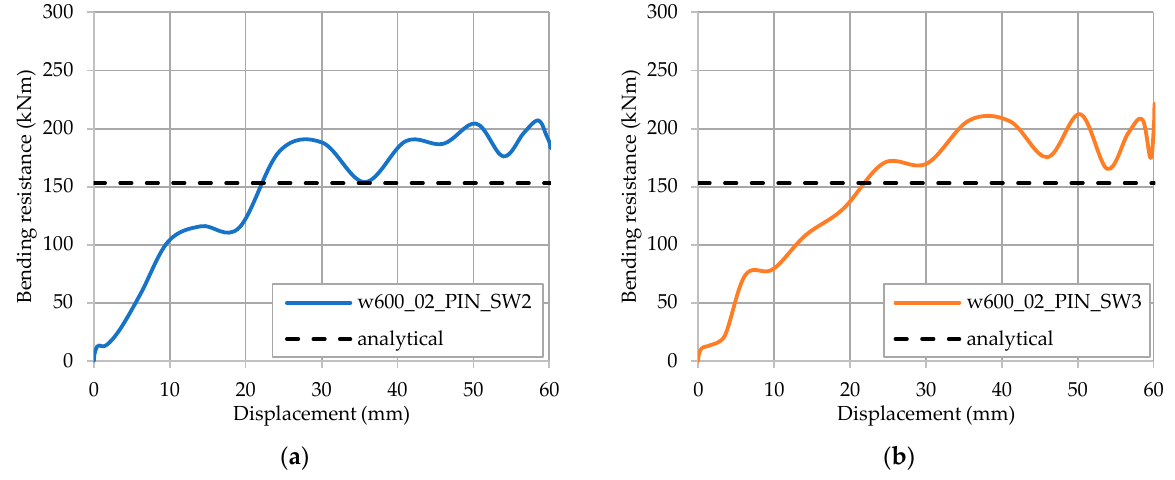
Figure 19. Bending resistance of the pinned beam for shear connectors spaced at 600 mm: ( a ) SW2; ( b ) SW3.